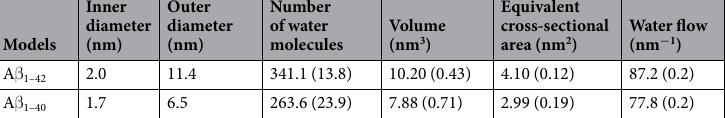
Table 2. Comparison of three-fold models of A β 1–40 and A β 1–42 fibrils shown in Fig.